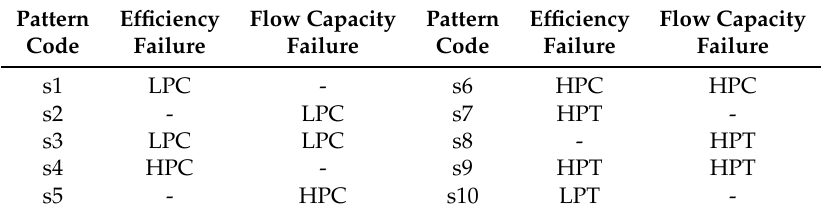
Table 8. Failure patterns of single component failure.